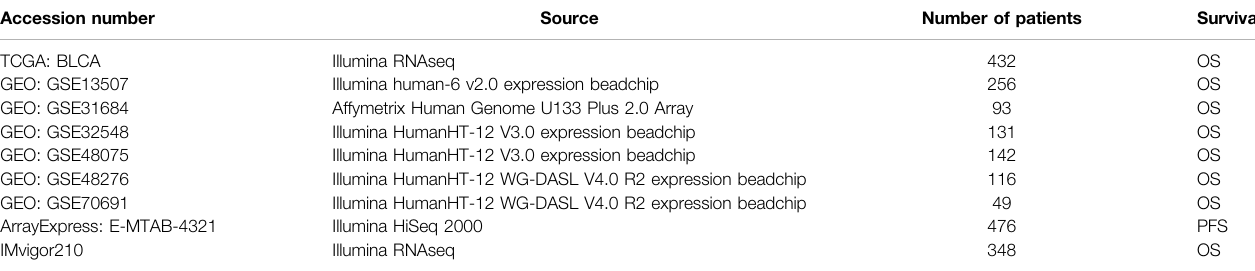
TABLE 1 | The gene expression pro fi les of bladder cancer included in this